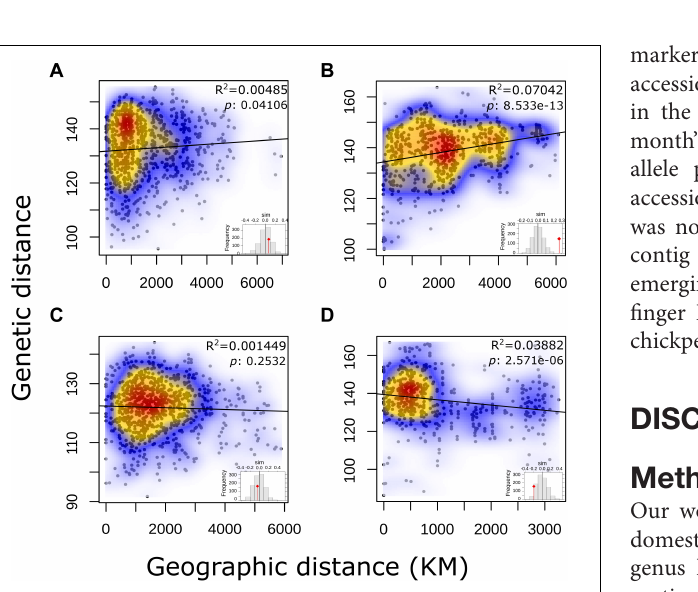
FIGURE 5 | Output of a Mantel test to determine Isolation-by-Distance in each of the STRUCTURE K = 4 defined groups of L. culinaris